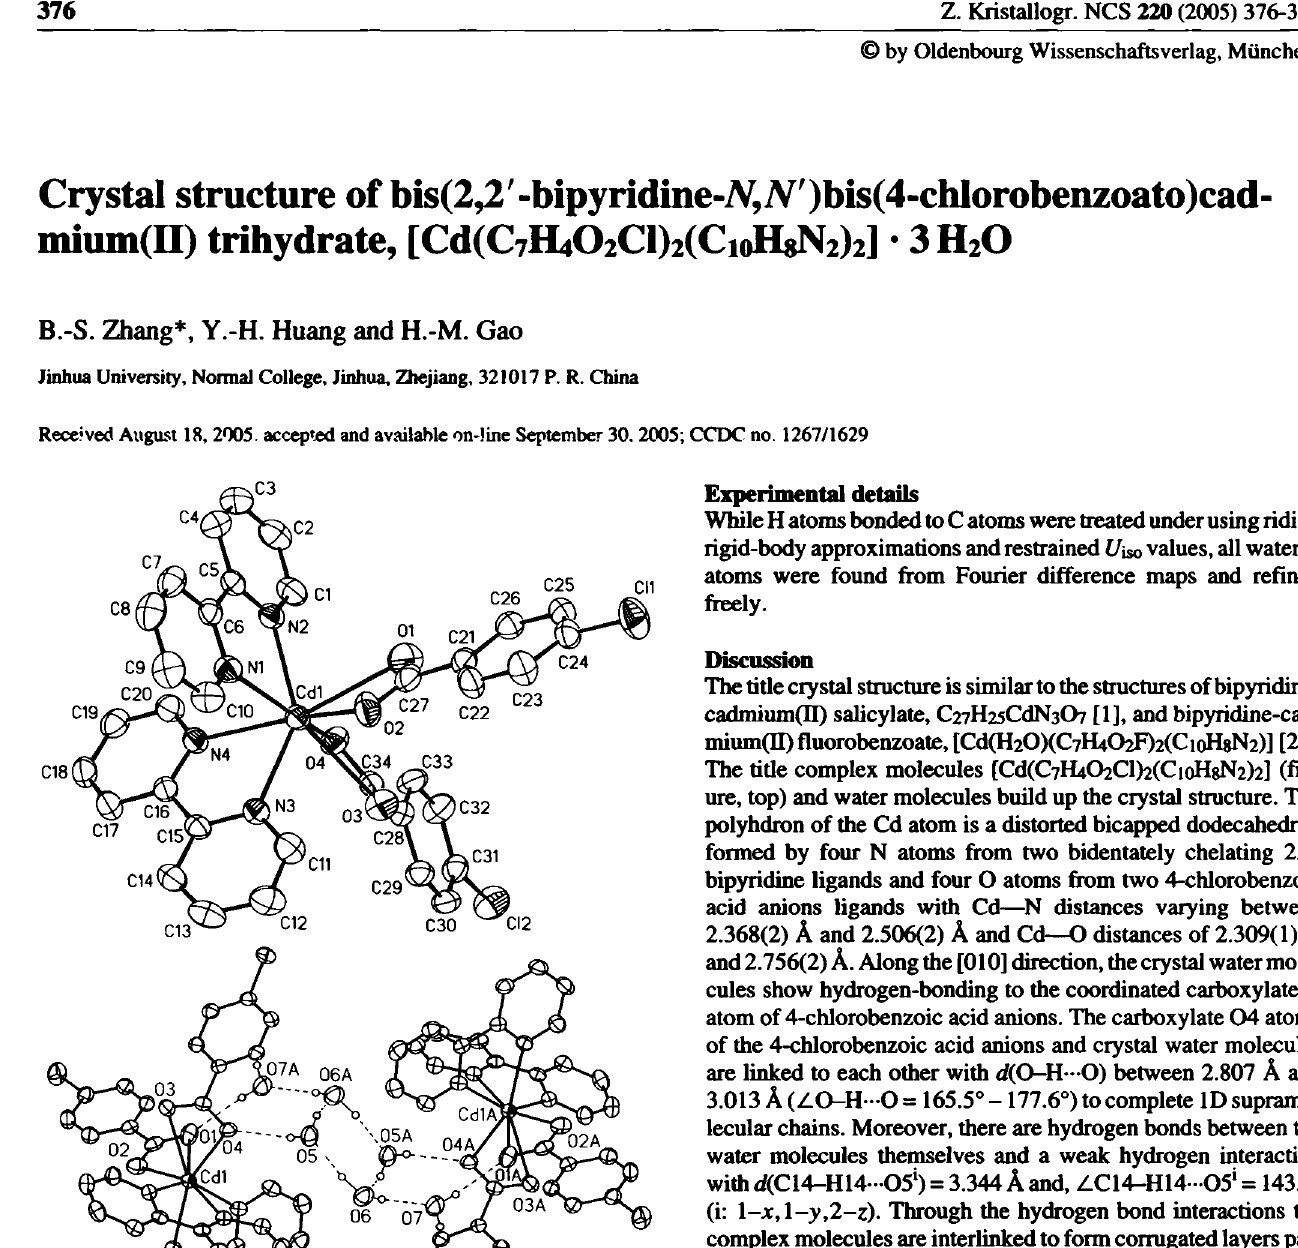
Table 1. Data collection and